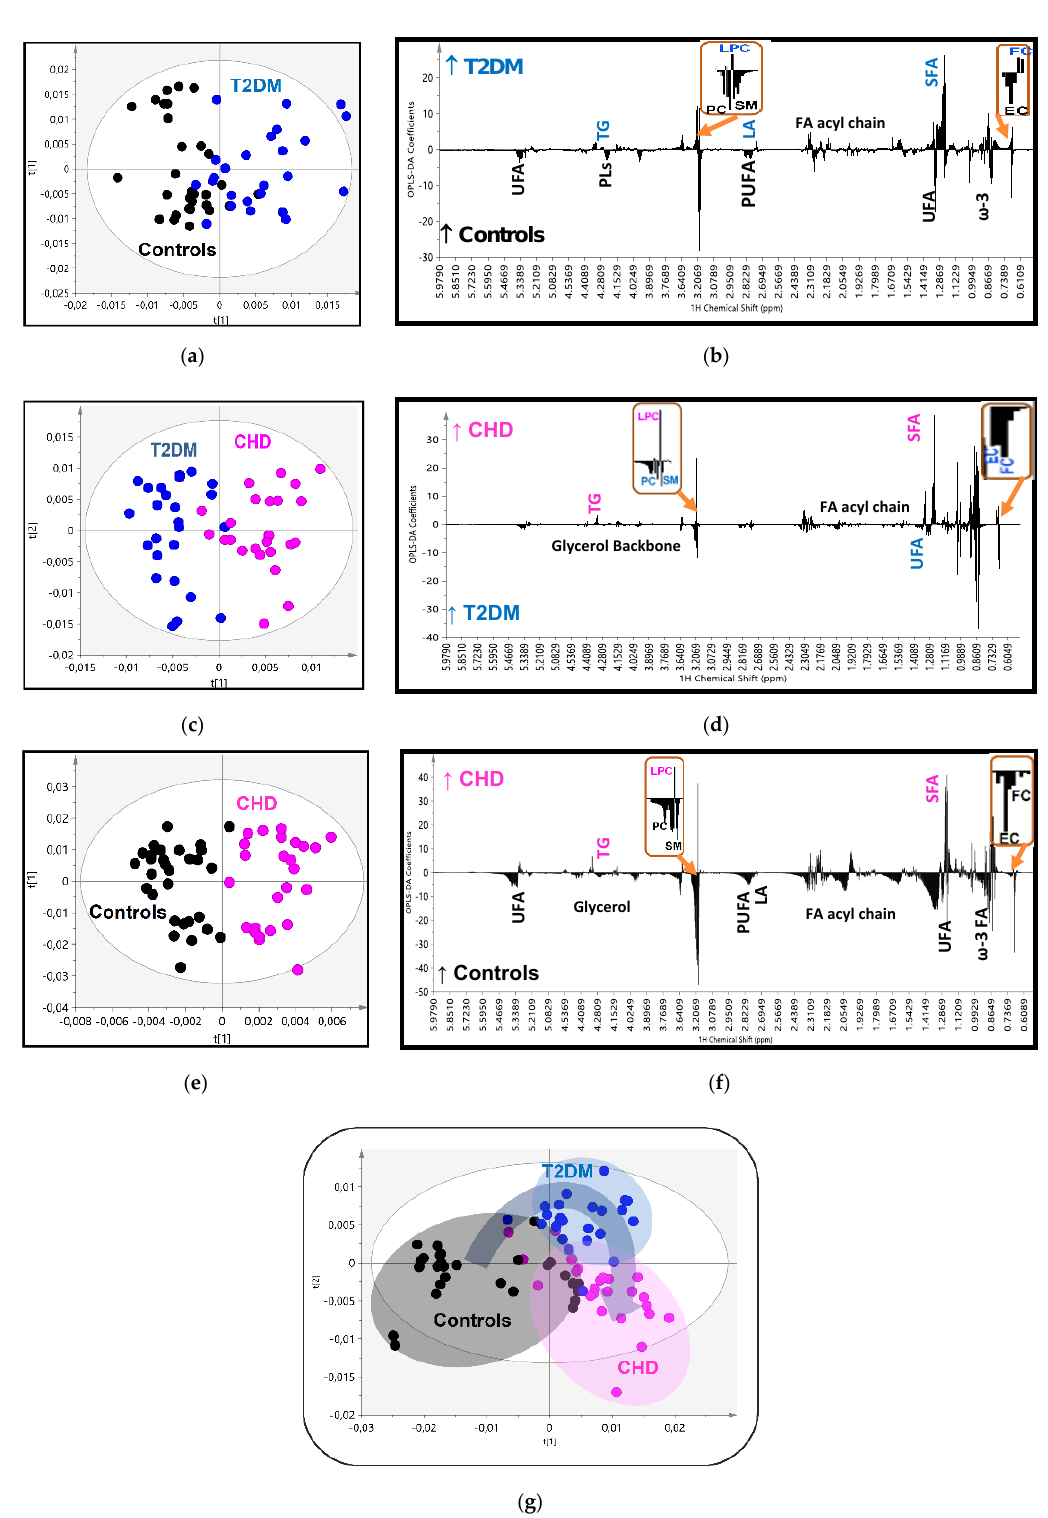
Figure 2. ( a ) OPLS-DA score plot of the HDL lipidomic data from 25 patients with Type 2 Diabetes (T2DM) (blue circles) and 30 controls (black circles); ( b ) the corresponding regression coefficient plot; ( c ) OPLS-DA score plot of the 25 patients with CHD (pink circles) and 30 controls (black circles); ( d ) the corresponding regression coefficient plot; ( e ) OPLS-DA score plot of the 25 patients with T2DM (blue circles) and 25 patients with Cononary Heart Disease (CHD) (pink circles); ( f ) the corresponding regression coefficient plot; and ( g ) OPLS-DA score plot of the three groups together.